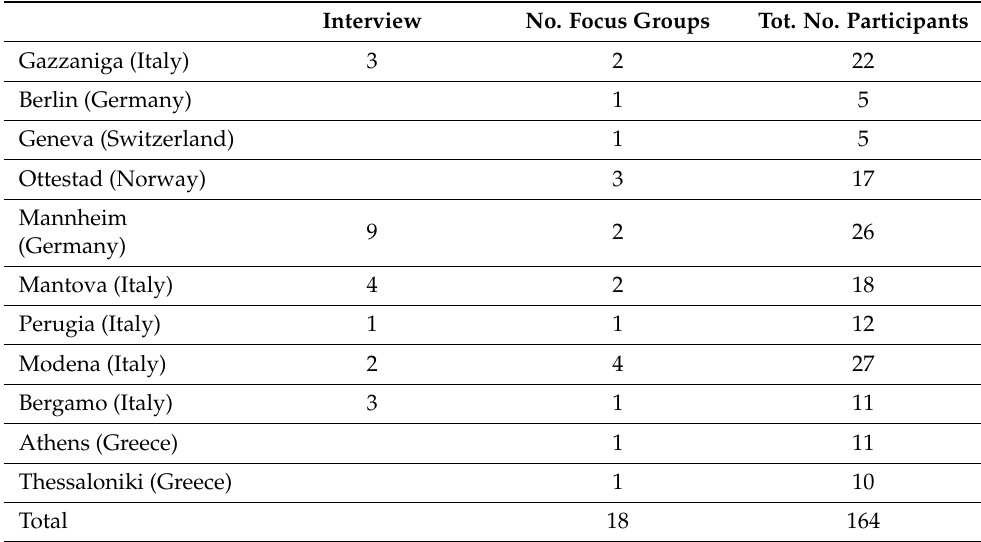
Table 2. Number of focus groups in each center and number of participants involved. Interview No. Focus